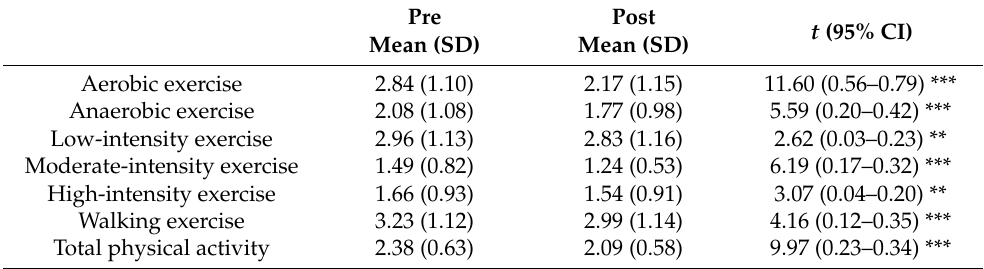
Table 2. Self-reported physical activity of periods pre and post COVID-19 pandemic which were assessed via a single questionnaire collected post COVID-19 pandemic ( n =